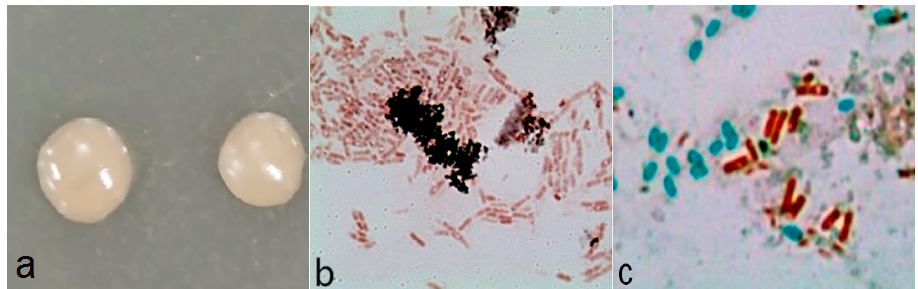
Figure 1. Morphological characteristics of A2: ( a ) the colonies of A2; ( b ) Gram staining; ( c ) spore staining.